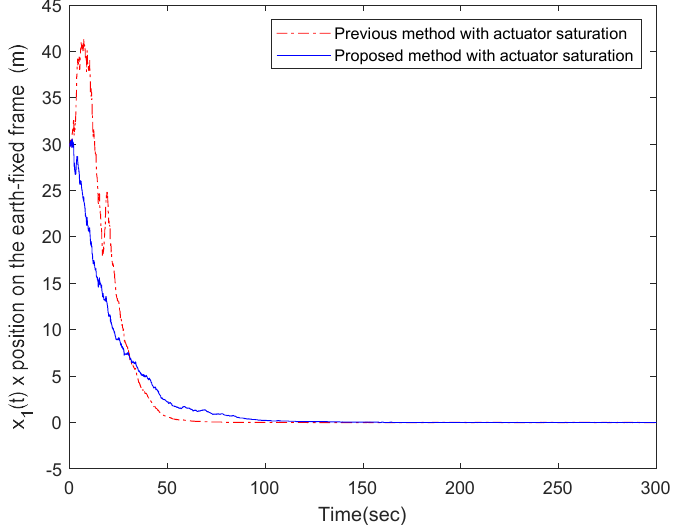
x t compared with [29]. 1